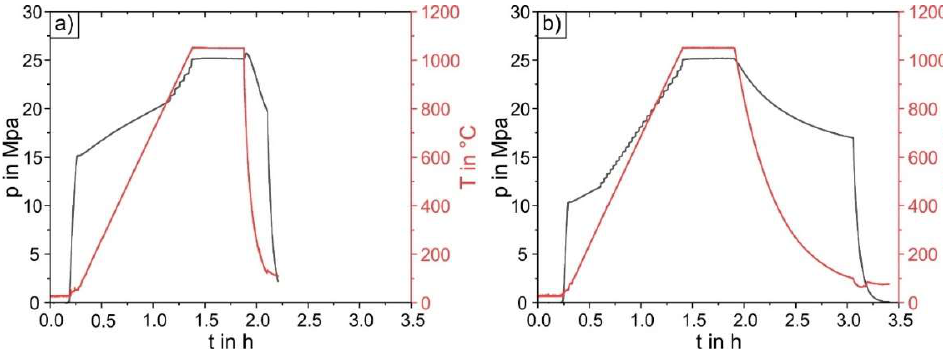
Figure 4. Exemplary p-T-t diagram of a HIP cycle at p = 25 MPa for the two cooling modes ( a ) URQ and ( b ) NC highlighting how pressure is build up within each section of the heat treatment. Table 3. Phase transformation temperatures as calculated using ThermoCalc software (pressure de- pendent calculations) as well as experimentally determined by means of dilatometry (DIL, ambient pressure) and electrical resistivity measurements (ERM, hydrostatic pressure) for varying cooling rates and pressures.